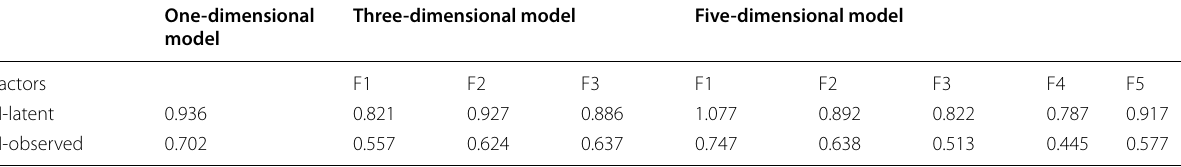
Table 3 Factor replication measures of the PFDI-20 models One-dimensional